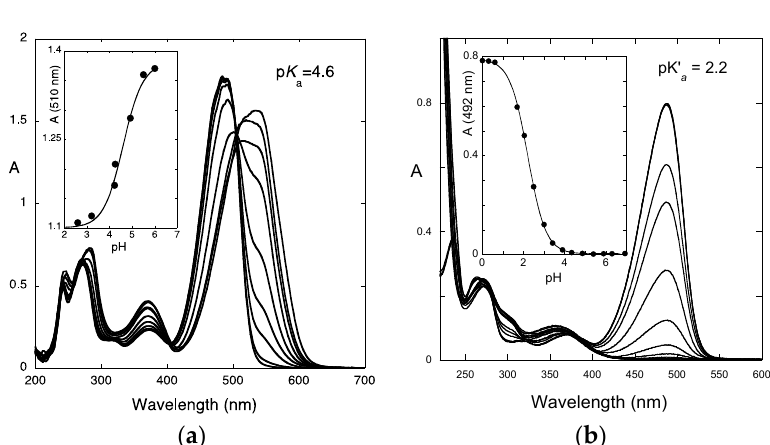
Figure 4. ( a ) Spectral variations immediately after a direct pH jump for compound 2 ; ( b ) the same at the equilibrium. With permission from RSC from ref. [15].